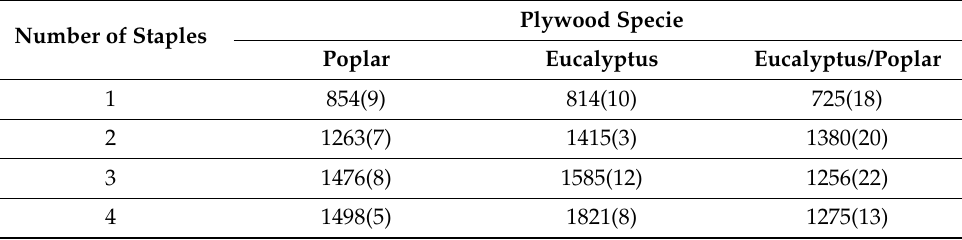
Table 2. Average comparisons of maximum withdrawal loads of one-row multi-stapled joints for plywood species with different numbers of